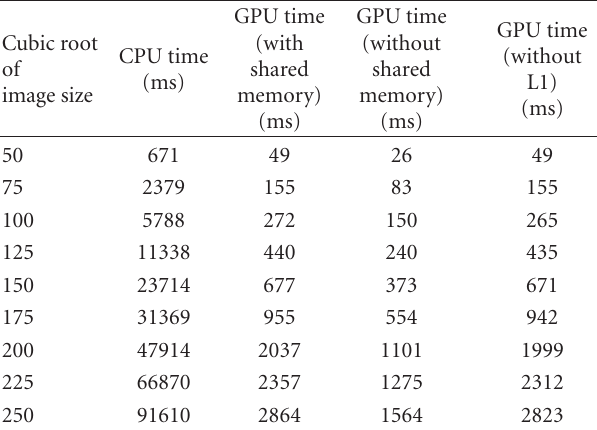
Table 3: Raw runtimes of the algorithm on the GTX480 system. Cubic root